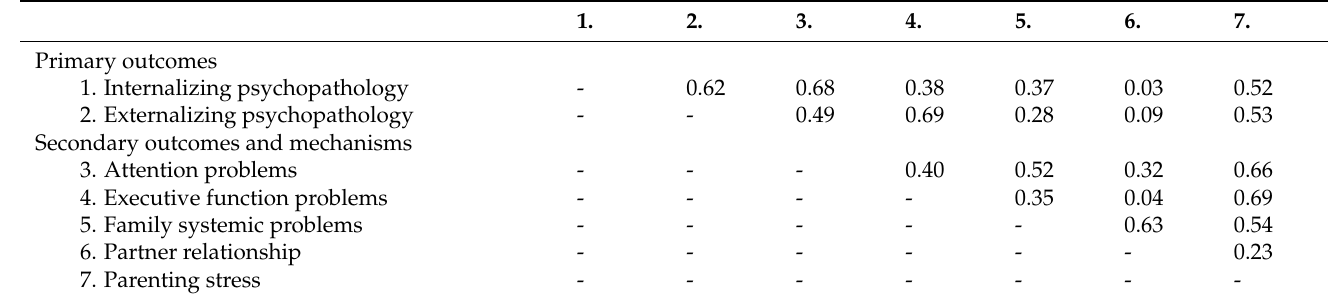
Table 5. Correlations between difference scores (post-test minus pre-test) of all outcome